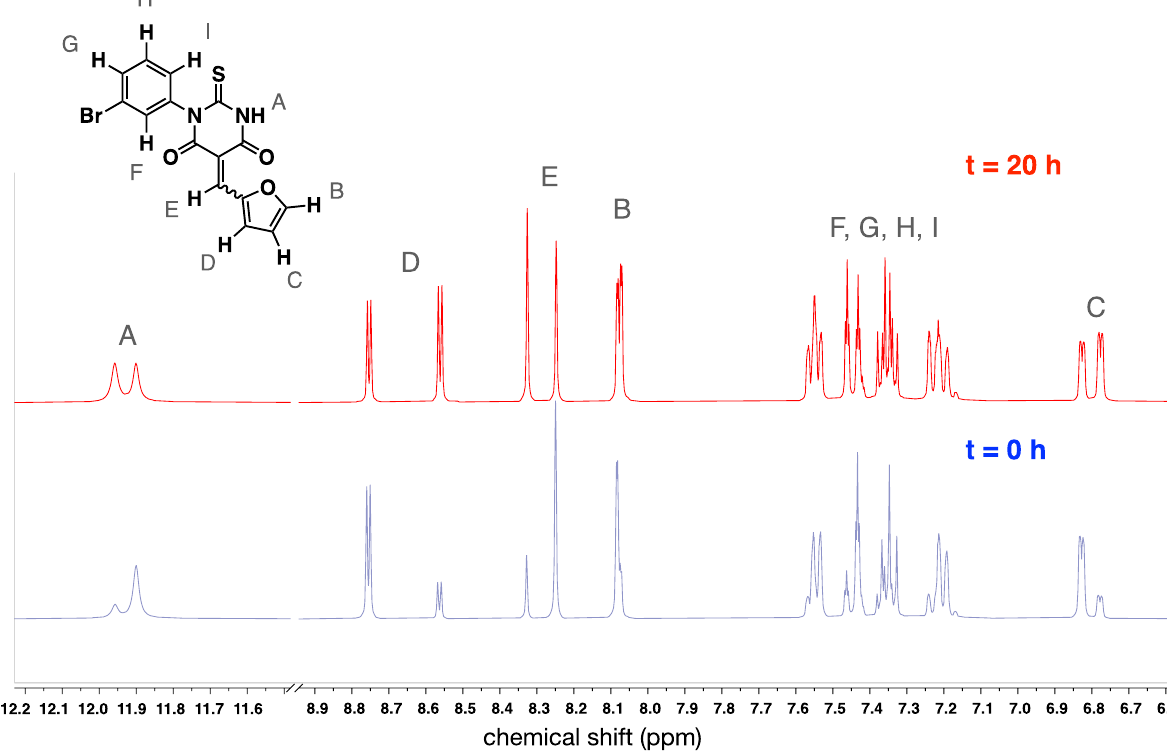
Figure 2. SMIFH2 is a mix of isomers that equilibrate over time. 1 H NMR spectra of the same sample were collected at two time points. The blue spectrum (bottom) corresponds to the SMIFH2 sample immediately after preparation in THF- d 8 . The uneven peak integrations are evident in the signals for protons A, B, C, D and E. The initial isomeric ratio was calculated as 3.5:1 by integration of major resonance at 8.25 ppm and minor resonance at 8.33 ppm for proton E. After 20 h at 25 °C (red spectrum; top), the peak integrations were similar for each isomer, reflecting equilibration to a ≈1:1 E : Z mixture (isomeric ratio 1.1:1 by integration of resonances at 8.33 ppm and 8.25